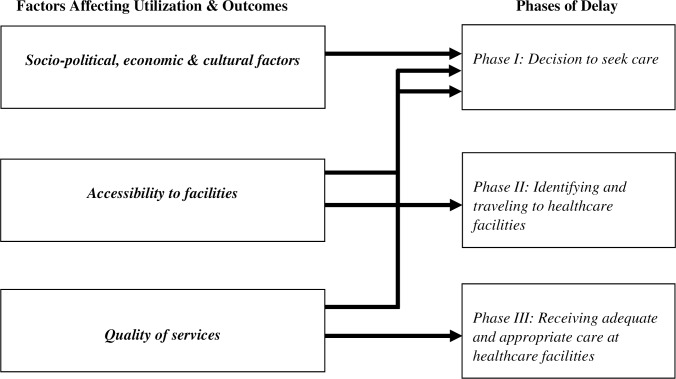
Three delays model.